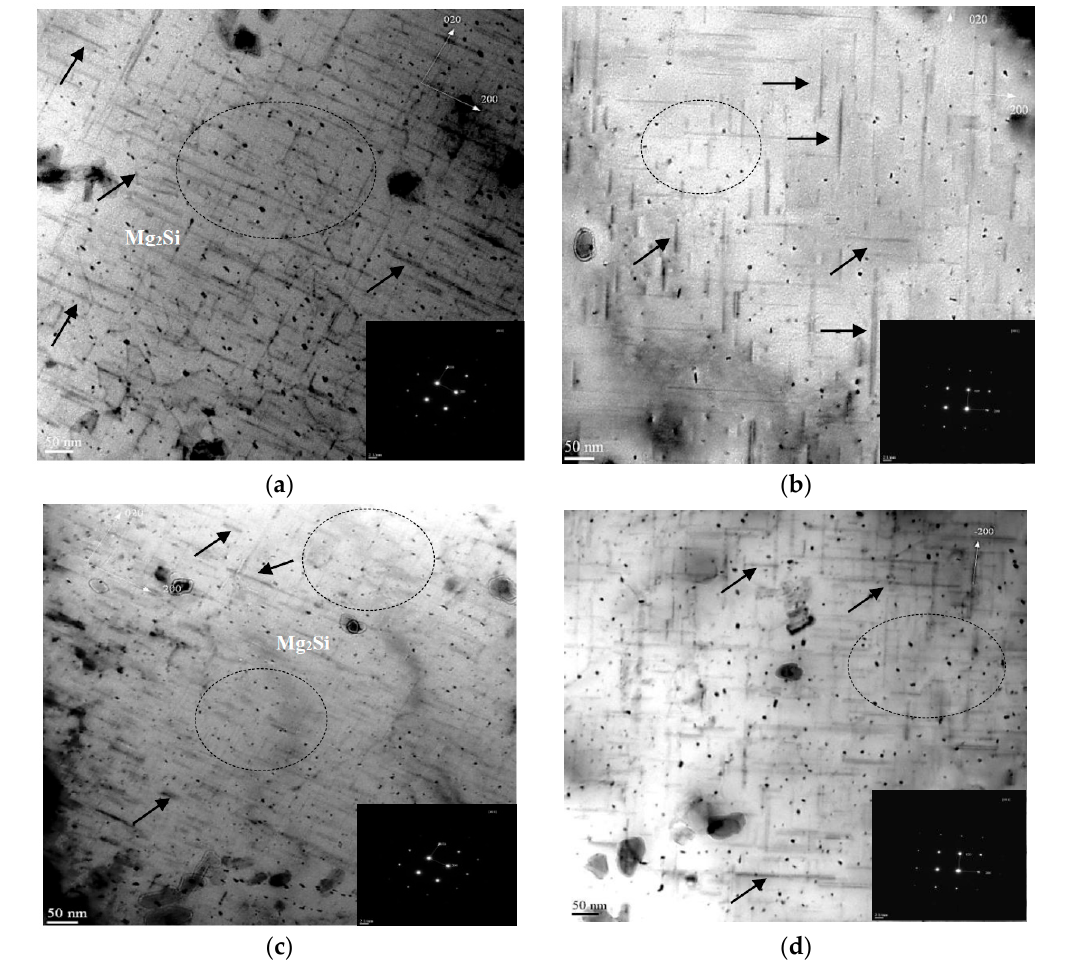
Figure 7. TEM images indicating the characteristics of Mg 2 Si precipitates of A357 semi solid alloys subjected to specific thermal aging conditions of A 3, A 5 , C 1 , and C 2 Cycles. ( a ) Two-steps thermal aging cycle, A 3 ; ( b ) Two-steps thermal aging cycle, A 5 ; ( c ) Interrupted thermal aging cycle, C 2 ; ( d ) Interrupted thermal aging cycle, C 1 .